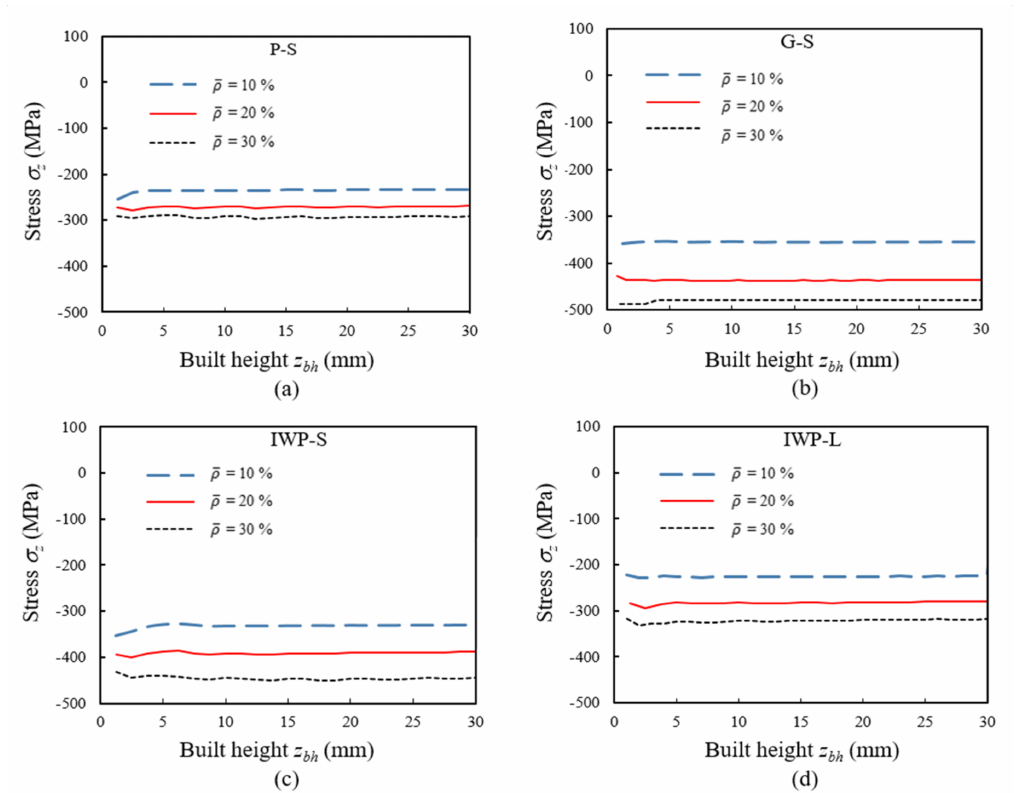
Figure 9. Stress evolution in build direction during the build height (30 mm) of TPMS for various relative densities: ( a ) PS, ( b ) G-S, ( c ) IWP-S, and ( d ) IWP-L.